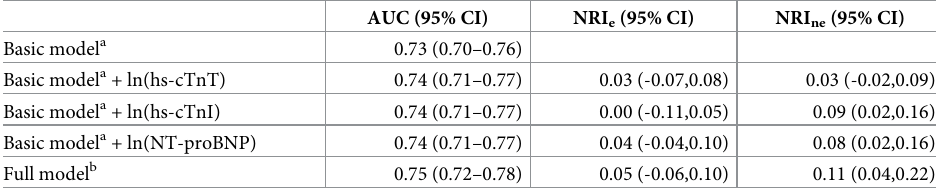
Table 4. Measures of model discrimination and